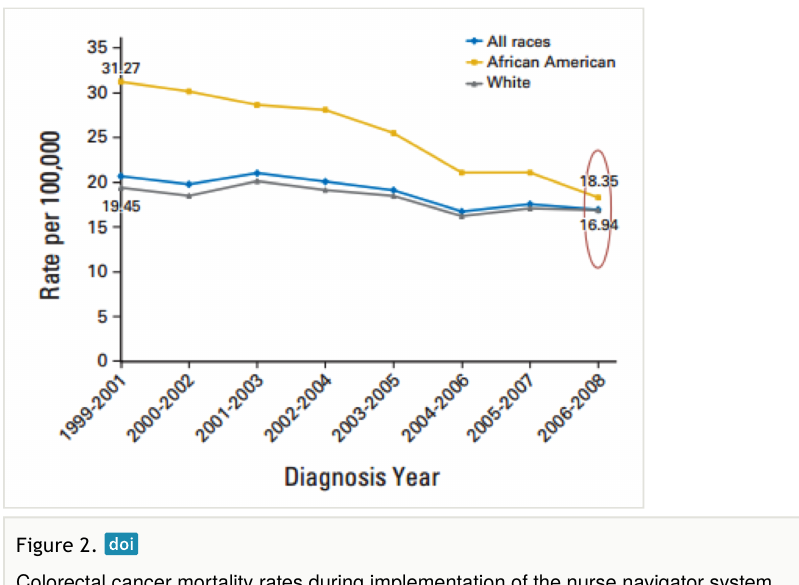
Figure 2. Colorectal cancer mortality rates during implementation of the nurse navigator